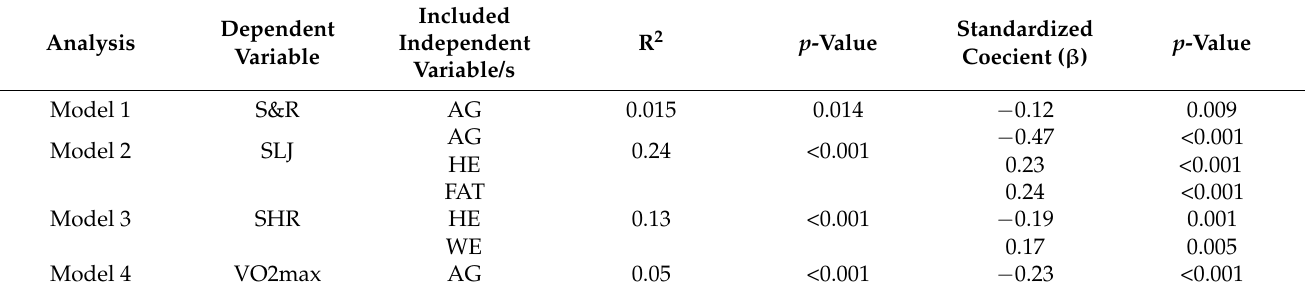
Table 4. Multiple linear regression analysis (using the stepwise method) of the relationship between fitness test results and AG, HE, FAT and